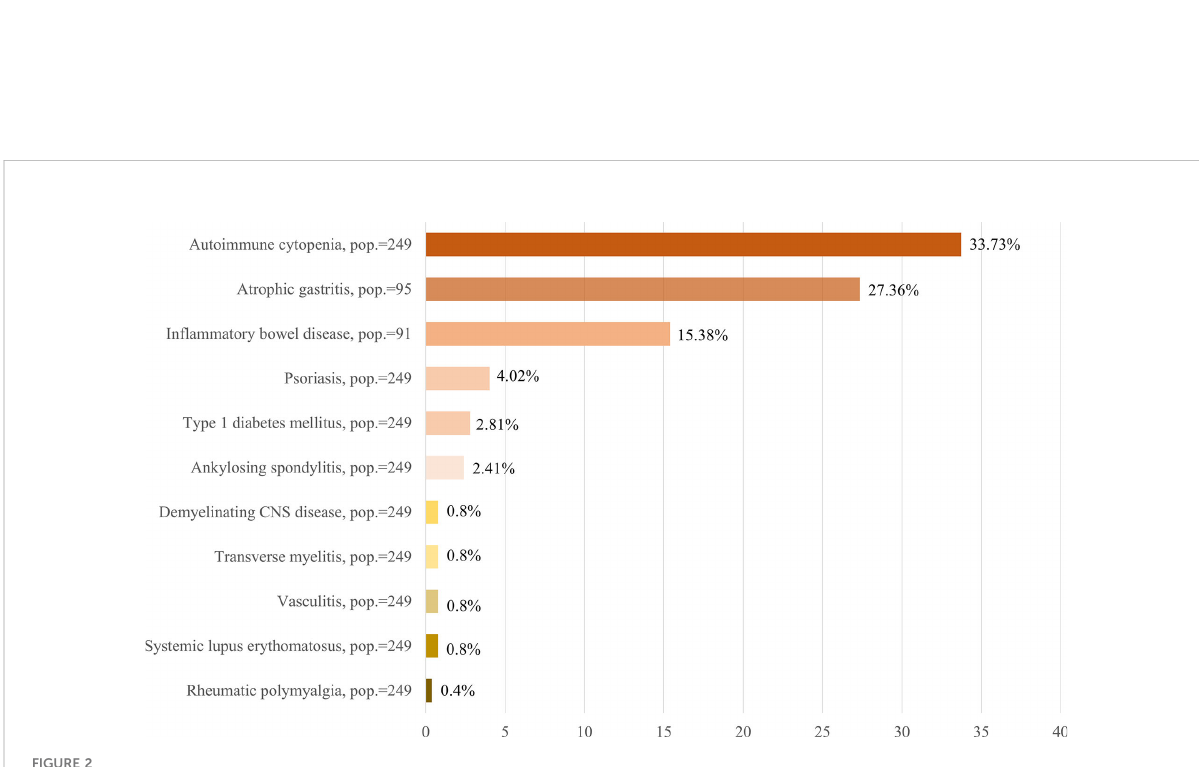
FIGURE 2 Summary of main immune complications of the CVID patients included in the GTEM-SEMI-CVID Registry. CNS, central nervous system. Pop., number of patients for whom information on the speci fi ed variable was available.